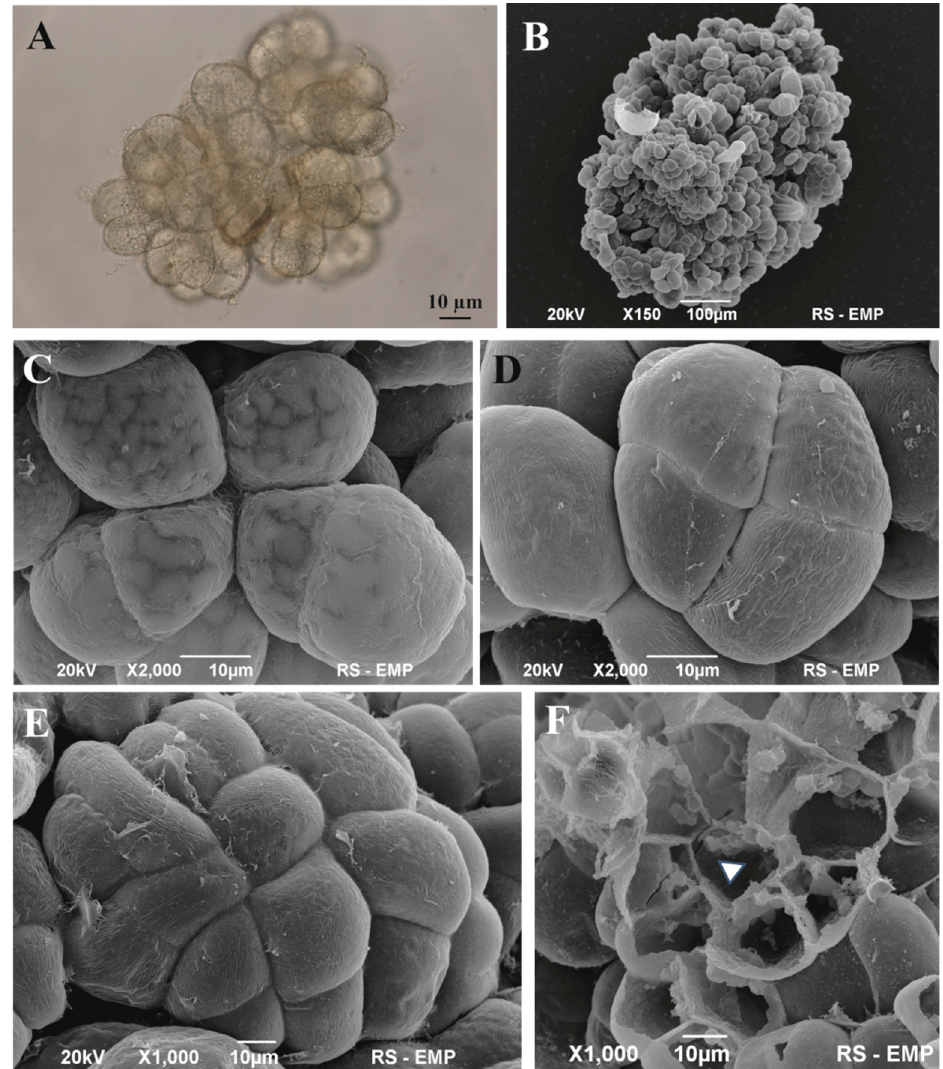
Figure 3. Analysis of established, differentiated types of cell suspension with evidence of some degree of cell organization in the structure of the Cyathea smithii cell suspension cultured in ½ MS medium supplemented with 2,4-D and BAP. ( A ) Cell aggregates observed with Nomarski contrast (squashed specimen). ( B ) SEM image of cell aggregate. ( C ) A thin cell wall facilitates the observation of large intracellular bodies. ( D ) Example of regular cell divisions forming a four-celled cluster. ( E ) Multicellular cluster with one centrally located cell regenerated on the surface of the cell aggregate. ( F ) Cross-section of a regular cluster regenerated from the cell aggregate with a centrally located triangular cell (white triangle) surrounded by eight cells of various locations, shapes, and sizes. ( A ) Bright-Field Light Microscopy; ( B – F ). SEM